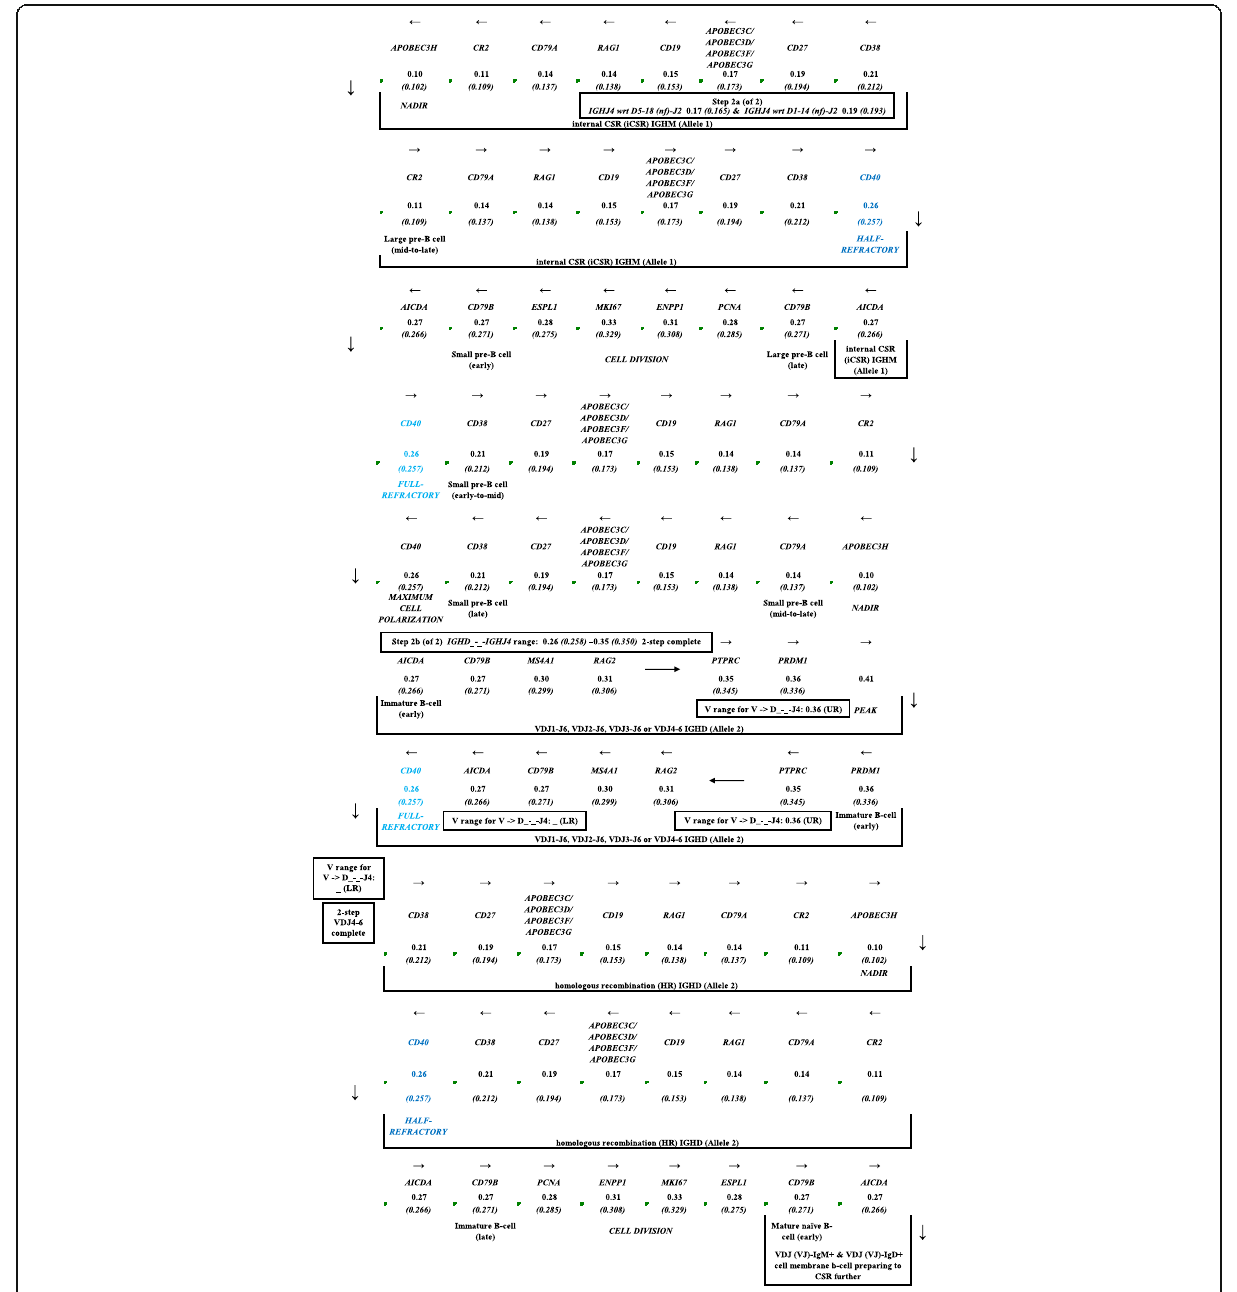
Fig. 2 Allele 2 (IGHD) 1-step and 2-step Ig heavy chain locus gene rearrangement recombination steps superimposed on the pressuromodulation map of B-cell differentiation stages. The Allele 2 one-step recombination step is IGHD_-_ and IGHJ1, IGHJ2 or IGHJ3 recombination that results in IGHD_-_ - IGHJ1 -J2 or -J3 (step 1 of 1) through the final IGHV_-_ and IGHD_-_-IGHJ1, IGHD_-_-IGHJ2 or IGHD_-_-IGHJ3 recombination that results in